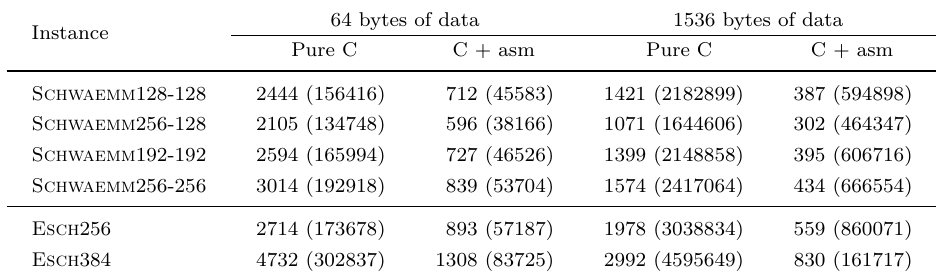
Table 13: Benchmarking results for the different instances of Schwaemm and Esch on an AVR ATmega128 microcontroller when processing 64 and 1536 bytes of data, respectively (in the case of Schwaemm the benchmarked operation is encryption and the length of the associated data is 0). The results are given in cycles/byte, with the number inside parentheses representing the total cycle count for processing the specified amount of data.